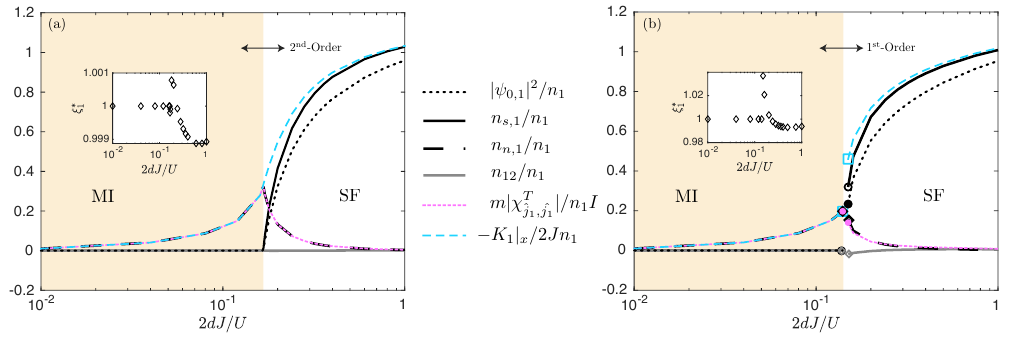
Figure 10: Transport quantities in two dimensions across the MI-to-SF second (left panel) and first (right panel) order transitions at fixed µ/ U = 1.4 and µ/ U = 1 for / U = 0.5 and U / U = 0.9, corresponding to the n = 2 MI lobes in Fig. 1(a) U d 12 12 and Fig. 1(b), respectively. The one-component densities n include the corrections of i the second-order quantum fluctuations. The tan-shaded area indicates the MI region. Thick black and grey lines indicate the QGW predictions for the superfluid density n s ,1 and the (vanishingly small) superfluid drag n respectively, while the black dashed 12 | 2 . and dotted lines refer to the normal component n and condensate fraction | ψ n ,1 0,1 Pink dotted and blue dashed lines are the contributions to n from the average s ,1 | , respectively. kinetic energy K and the intraspecies current response function χ T i x ˆ j ,ˆ j i i (Insets) Renormalization of the effective mass across the MI-to-SF transitions due to the collisionless